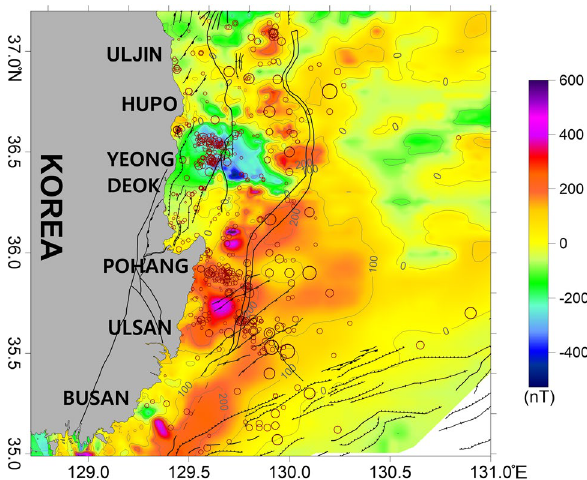
Figure 6. Magnetic anomaly map of the study area. The major geologic structures and symbols of the earthquakes are the same as those in Fig. 2. This figure was generated using the Surfer software (https:// www. golde nsoft ware. com/).